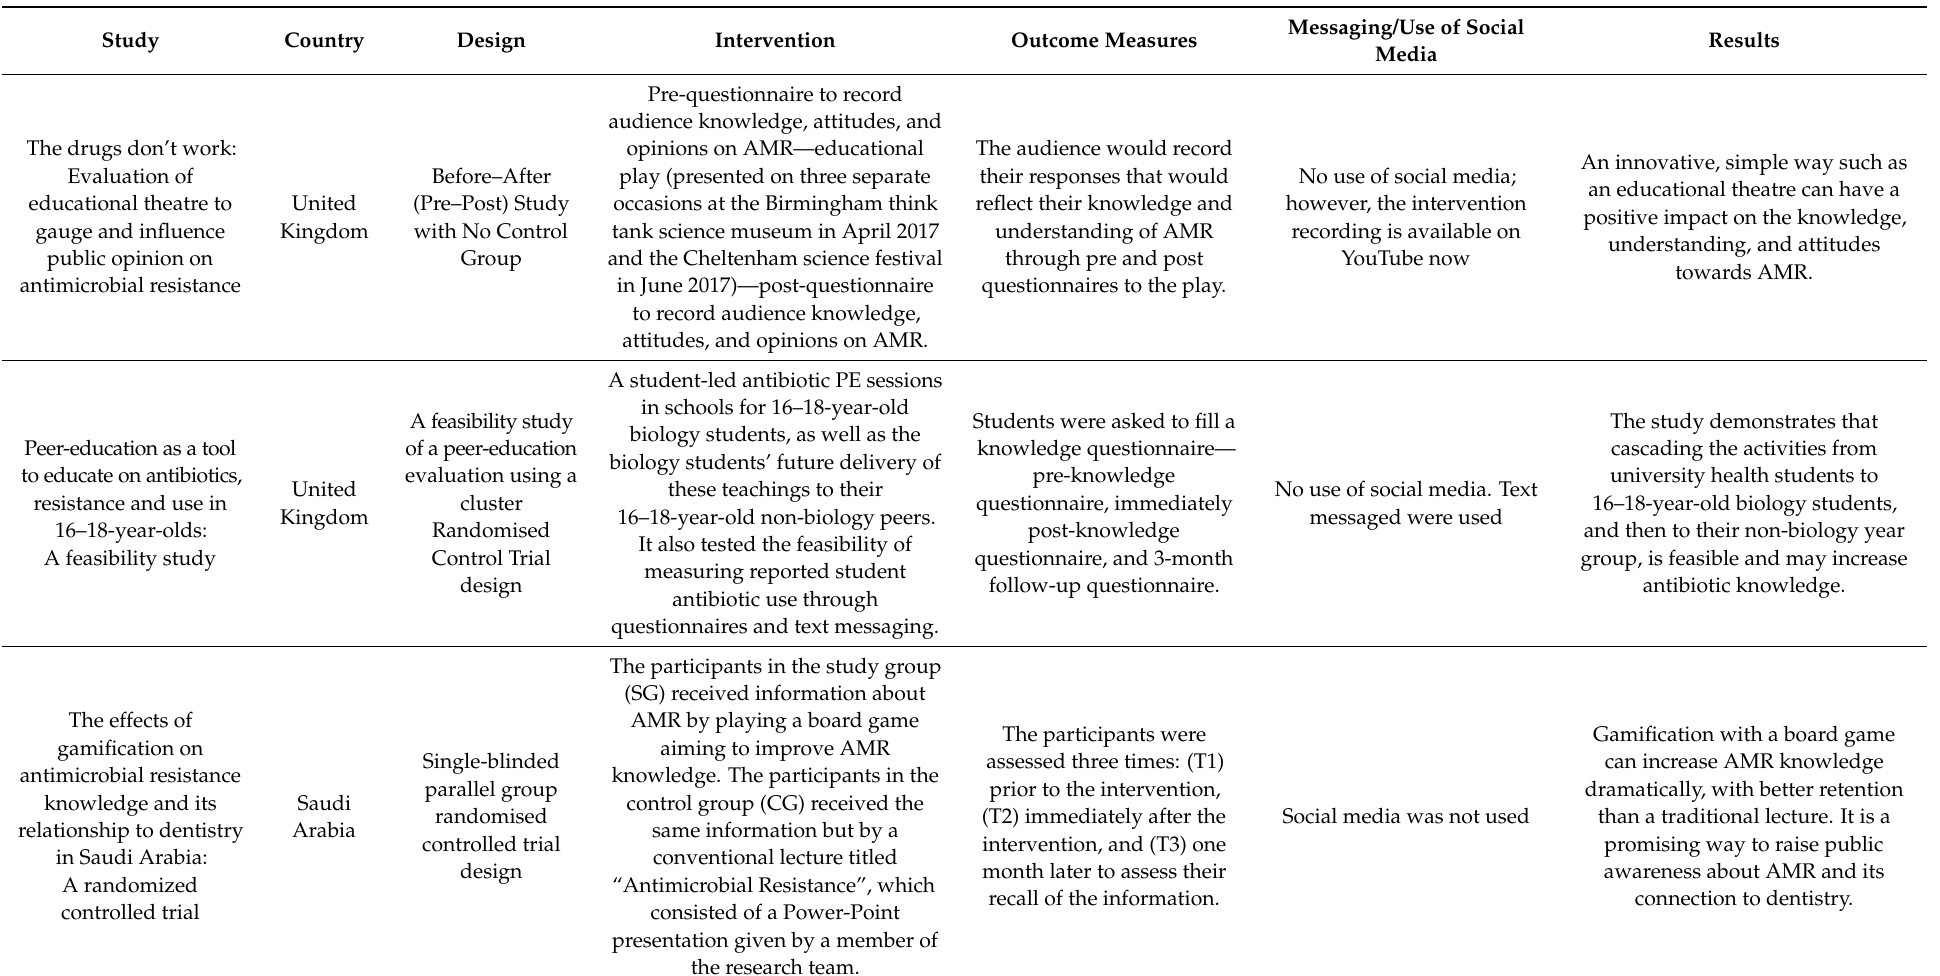
Table 2. Details of